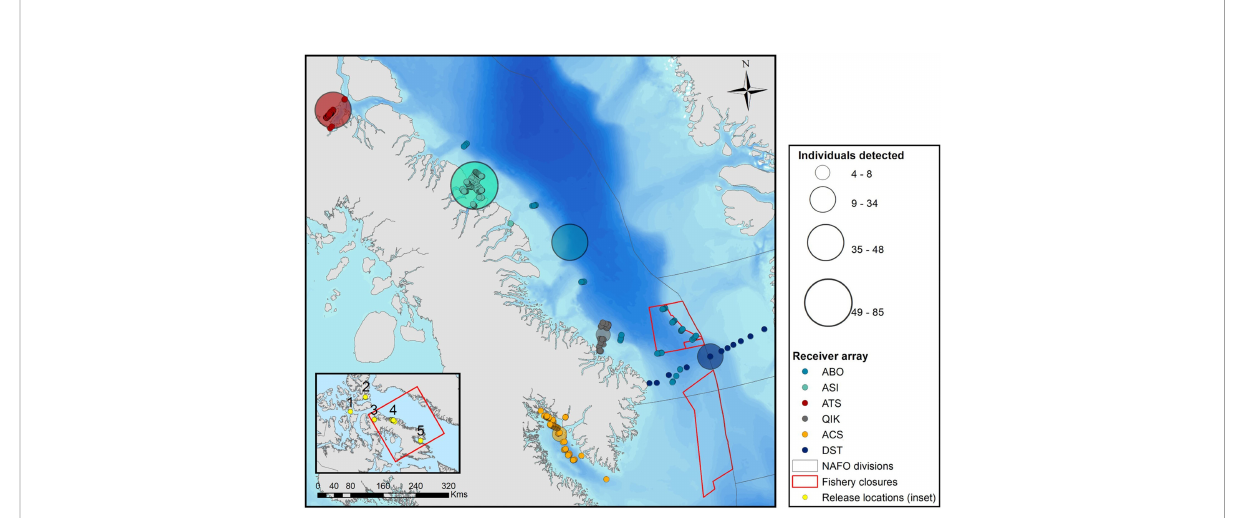
FIGURE 1 Locations of acoustic receivers used to monitor the presence of tagged Greenland sharks across four coastal regions of Nunavut (Eastern Canadian Arctic) and offshore Baf fi n Bay. Points are coloured by receiver array, where solid points represent the locations of individual receivers and semi-transparent points are scaled in size to represent the total number of individuals detected per array. Release locations of tagged Greenland sharks are depicted by yellow circles in the inset map and are numbered as follows: 1) Resolute Bay, 2) Grise Fjord, 3) Tremblay Sound, 4) Scott Inlet, 5) Cumberland Sound. [Colour